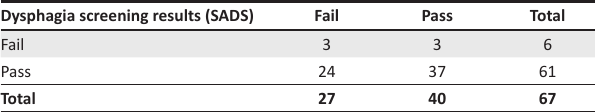
TABLE 4: Sensitivity and specificity of the dysphagia triage checklist. Dysphagia screening results